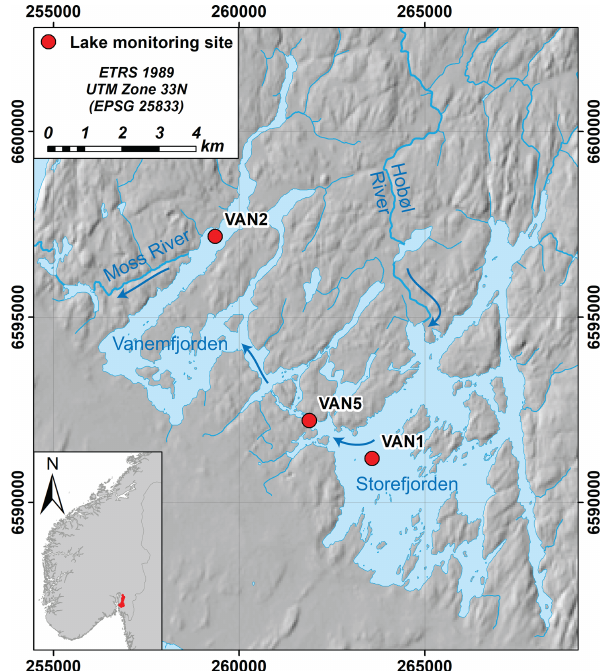
Figure 1. Vansjø in southeastern Norway, showing the two main basins, the larger eastern basin (Storefjorden) and Vanemfjorden (the study basin). The two basins are connected by a narrow chan- nel. The largest tributary to Vansjø is the Hobøl River. Main Nor- wegian Institute for Water Research (NIVA) monitoring sites are shown, and arrows show the dominant flow directions. Here, we use data from VAN2. Hillshade © Kartverket (https://www.kartverket. no/, last access: 9 May 2022); hydrologic data © NVE (https: //www.nve.no/english/, last access: 9 May